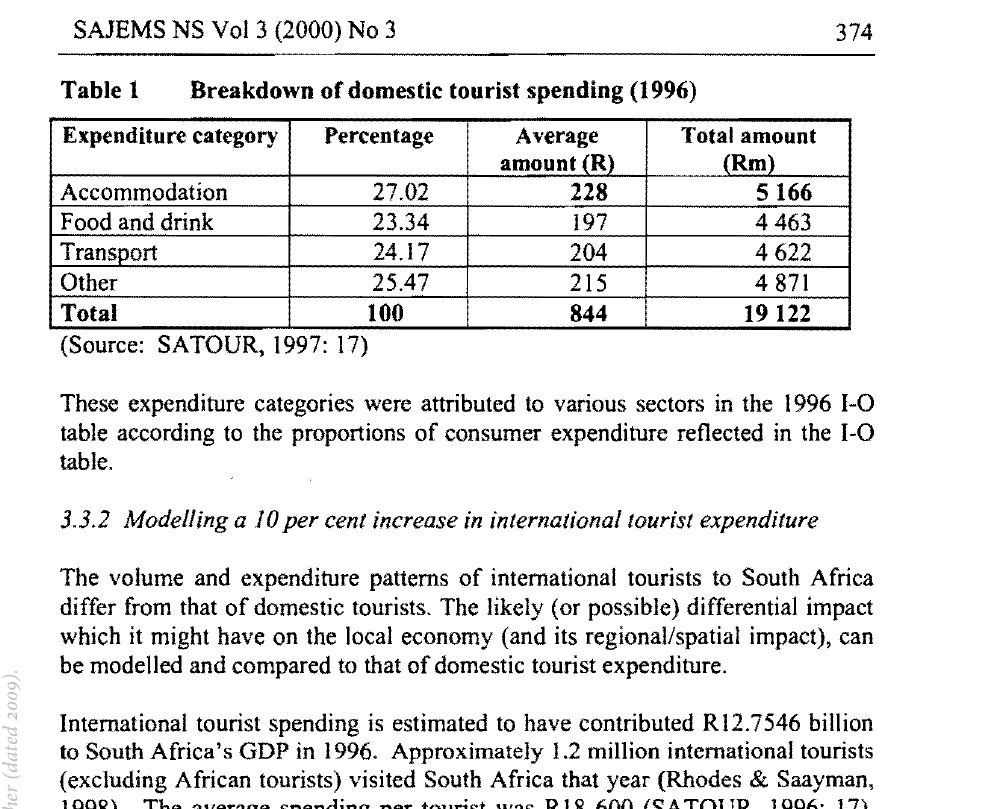
Breakdown of international tourist spending (1996) Expenditure